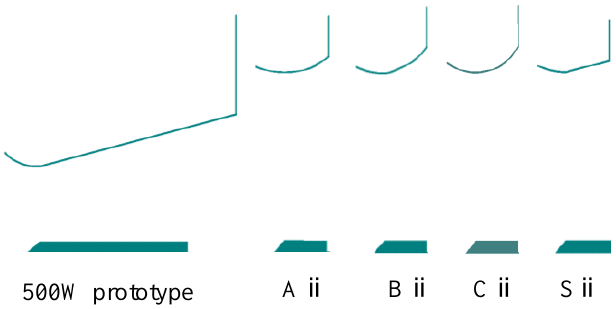
Figure 9. Sectional shapes of wind - lens.